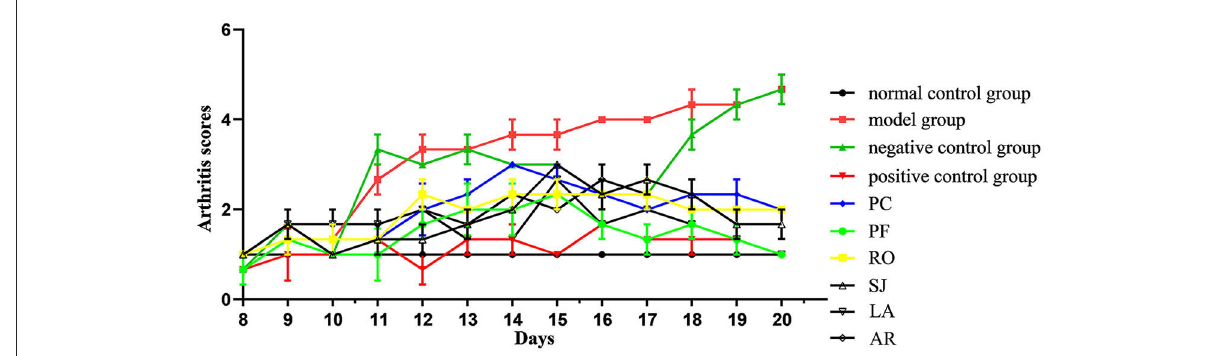
FIGURE4 Arthritis scores of rats with CFA-induced adjuvant arthritis. The scores of normal control group, model (CFA) group, negative control (NC) group, positive control group, PCEO group (PC), PFEO group (PF), ROEO group (RO), SJEO group (SJ), LAEO group (LA), AREO group (AR) are shown with different color lines.